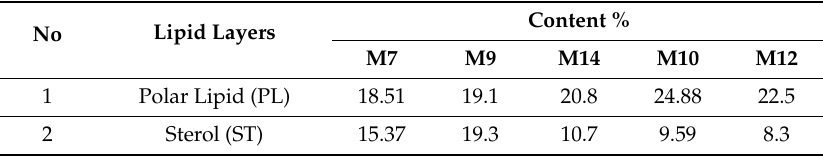
Table 5. Lipid class composition (% of total